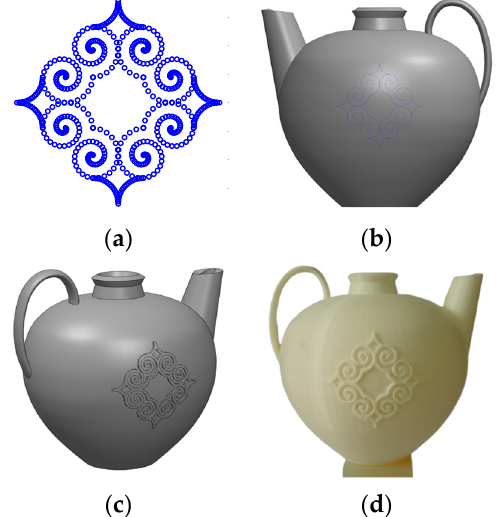
Figure 21. Surface texturing. ( a ) Point cloud of surface texture [69]; ( b ) point cloud of surface texture injected into the solid CAD model of ewer; ( c ) solid CAD model of the ewer with surface texture; ( d ) 3D printed physical model of the ewer with surface texture.